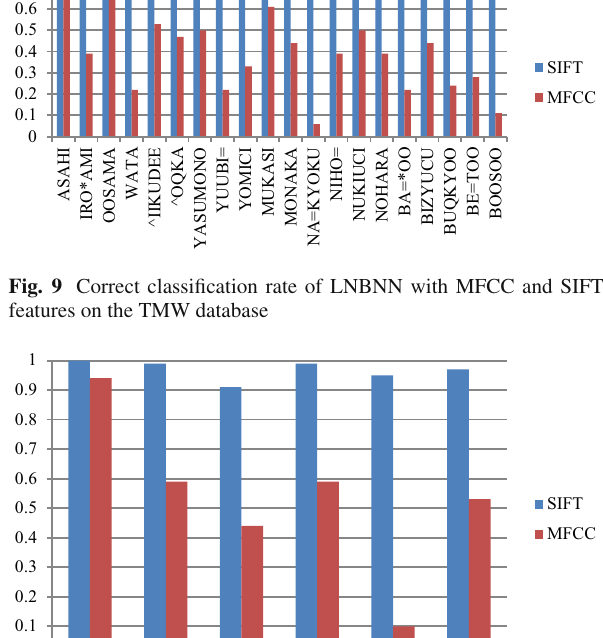
Fig. 10 Correct classification rate of LNBNN with MFCC and SIFT features on the JVPD database thanthefamiliarMFCCinspeechperceptionwhencombined with the LNBNN classifier.